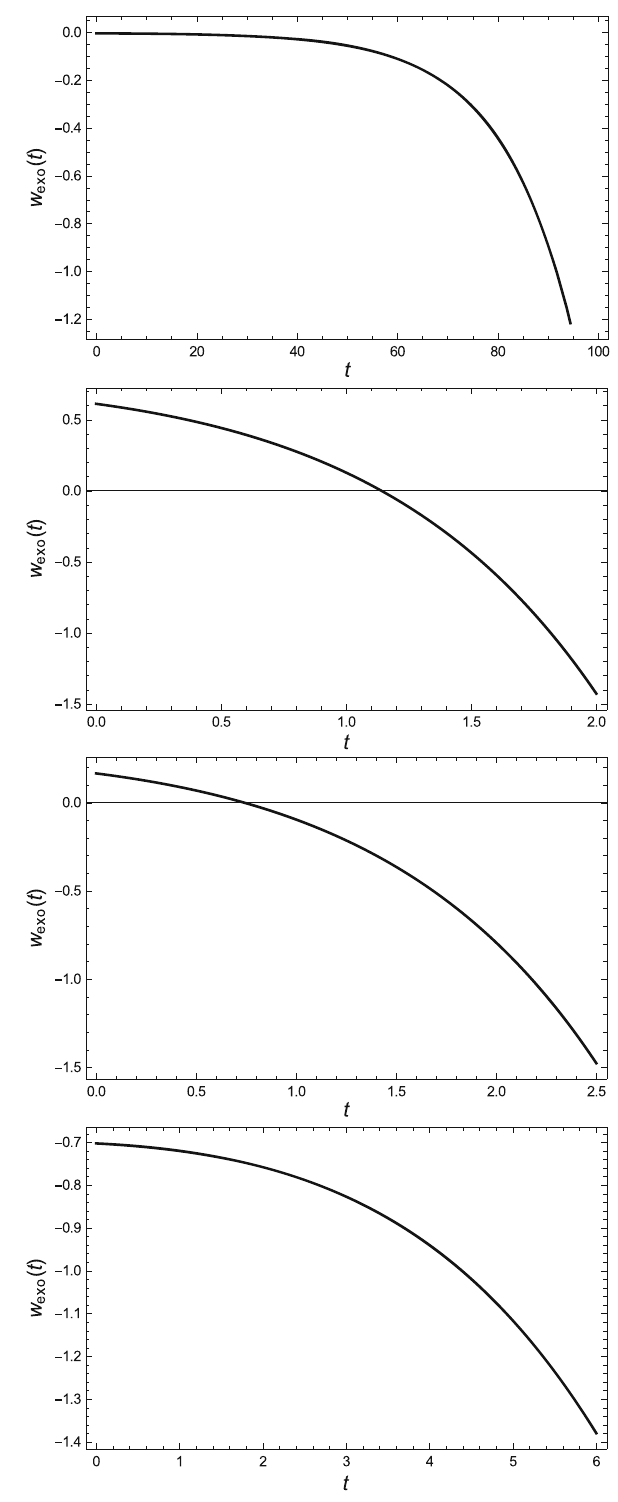
Fig. 3 Equation of state of the exotic fluid for reconstructed f ( T ) model from a constant jerk parameter. λ is fixed at 0 . 035 and A = 2, B = 1. The top graph represents plot of ω = 0, the second from the top is for ω = 1, third is for ω = 1 , while the graph on the bottom is for 2 ω = − 1